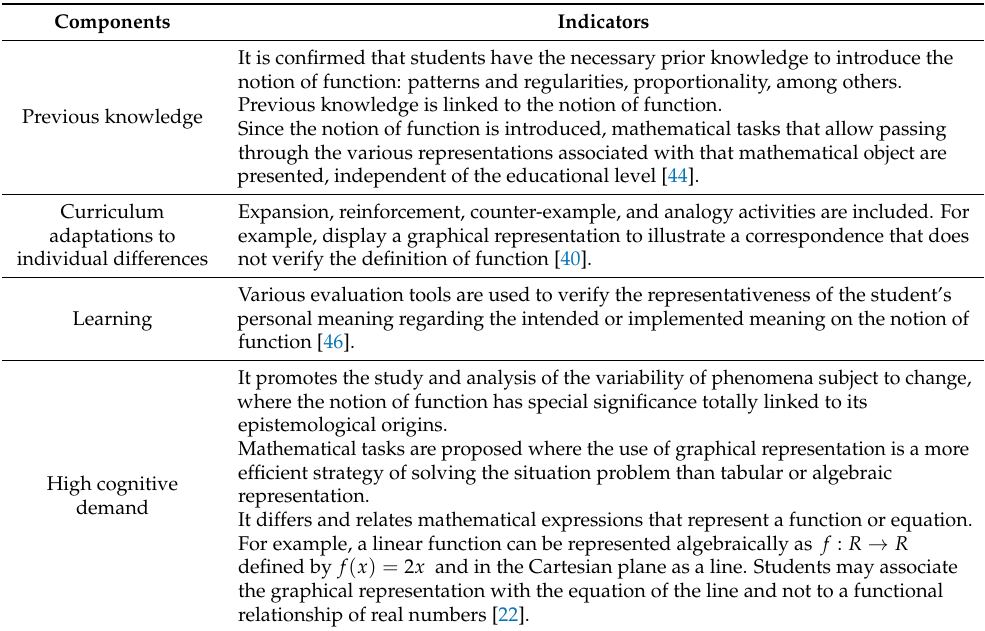
Table 2. Cognitive suitability for teaching functions.